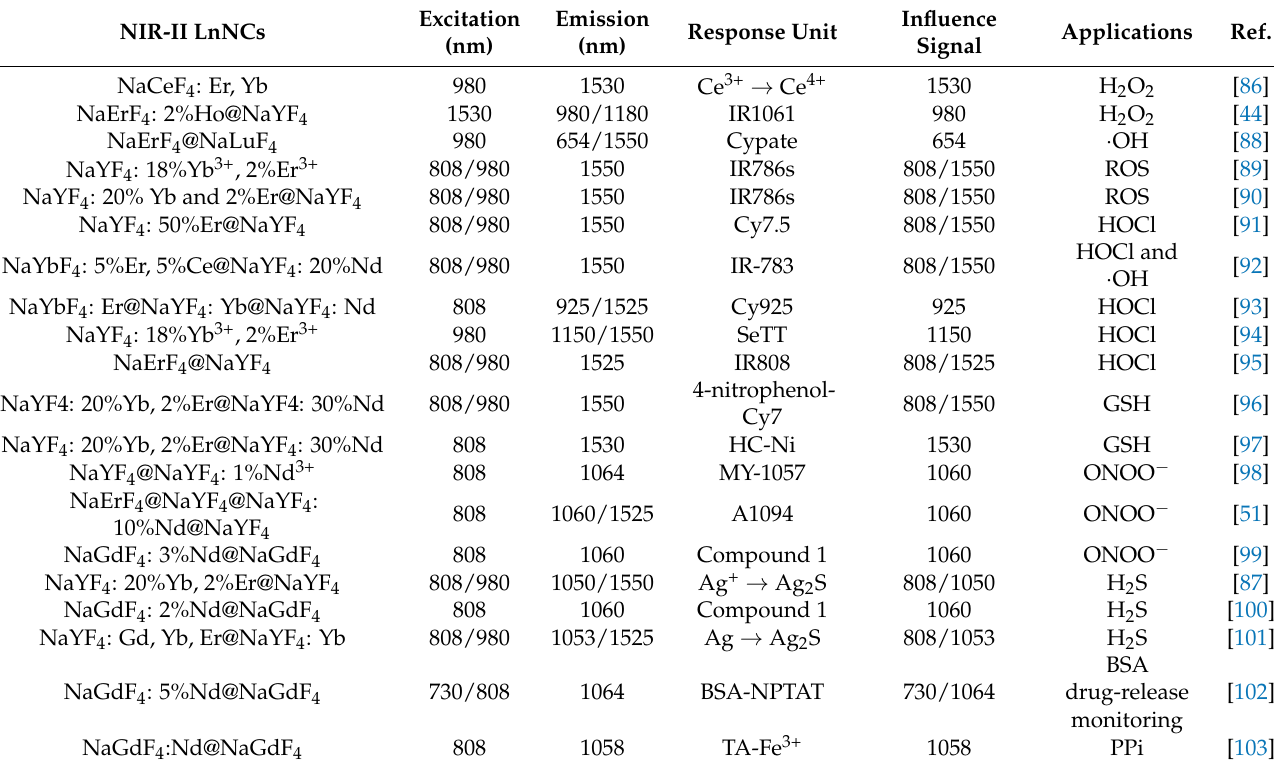
Table 1. Typical NIR-II LnNCs-based Bio/chemo